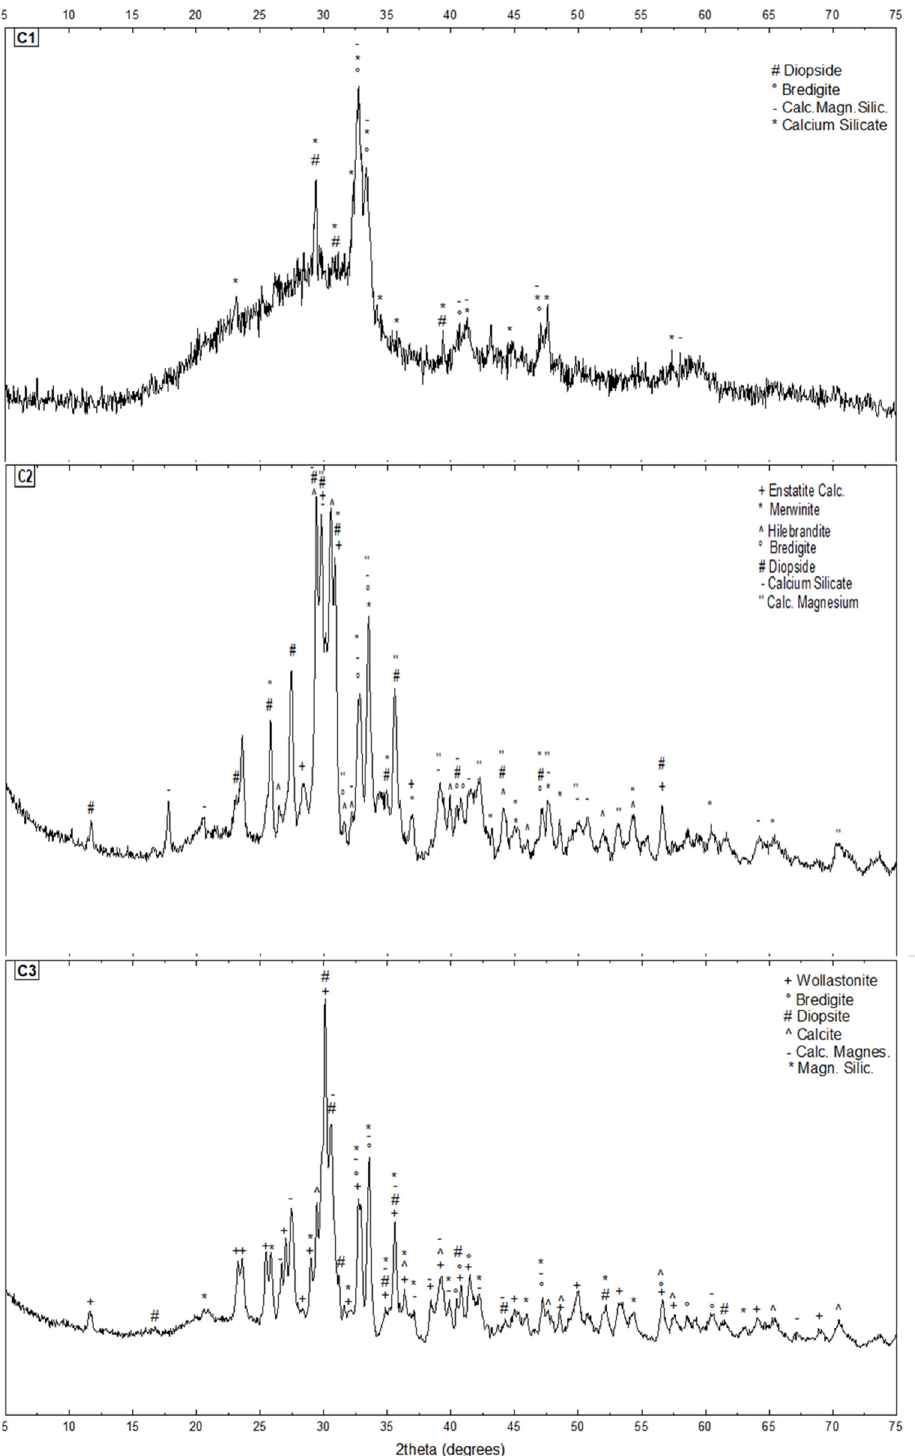
Figure 3. X-ray diffraction patterns of C1 (835 °C), C2 (1000 °C), and C3 (1100 °C) before the immersion in SBF (0 day).